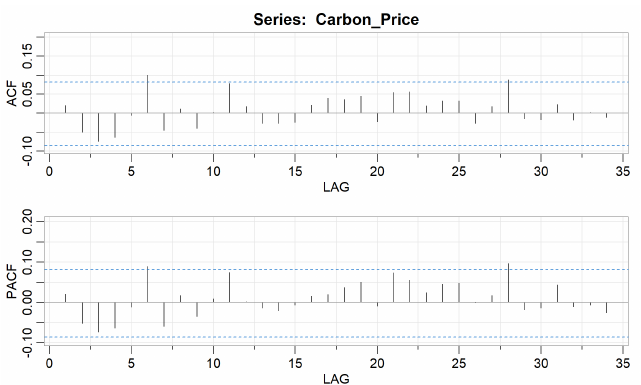
Figure 11. ACF and PACF of the Log − Differenced Carbon Emissions Dataset.